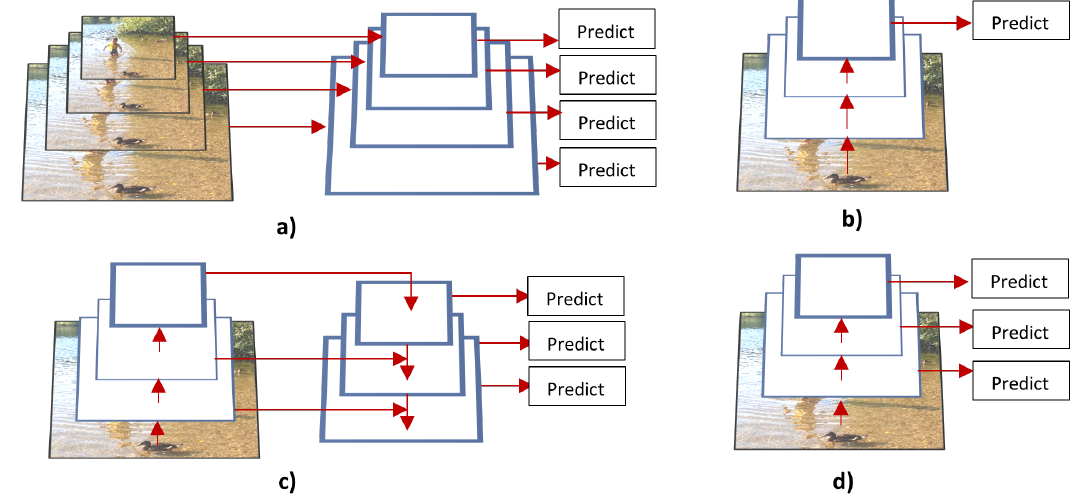
Figure 11. Different types of strategies to deal with scale variance. ( a ) Featurized image pyramid. ( b ) Single feature map. ( c ) Feature Pyramid Network. ( d ) Pyramidal feature hierarchy